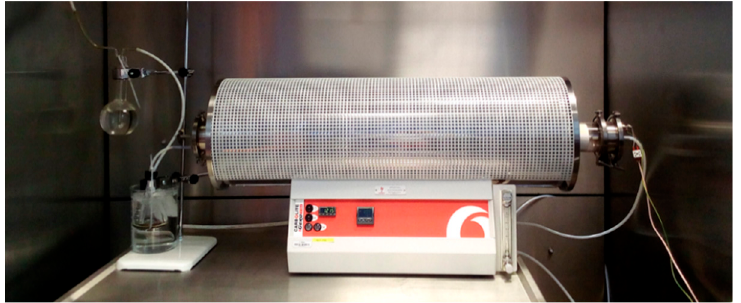
Figure 1. Experimental